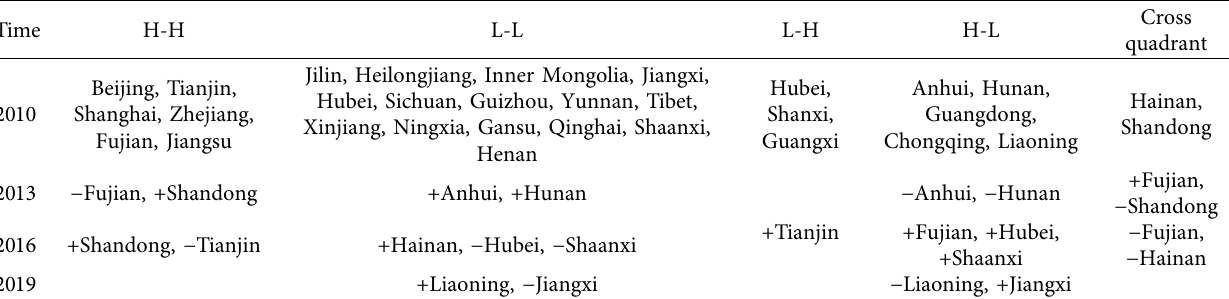
Figure 3: Spatial clustering characteristics of China’s construction industry. Table 3: Moran’s index scattered distribution map province distribution.